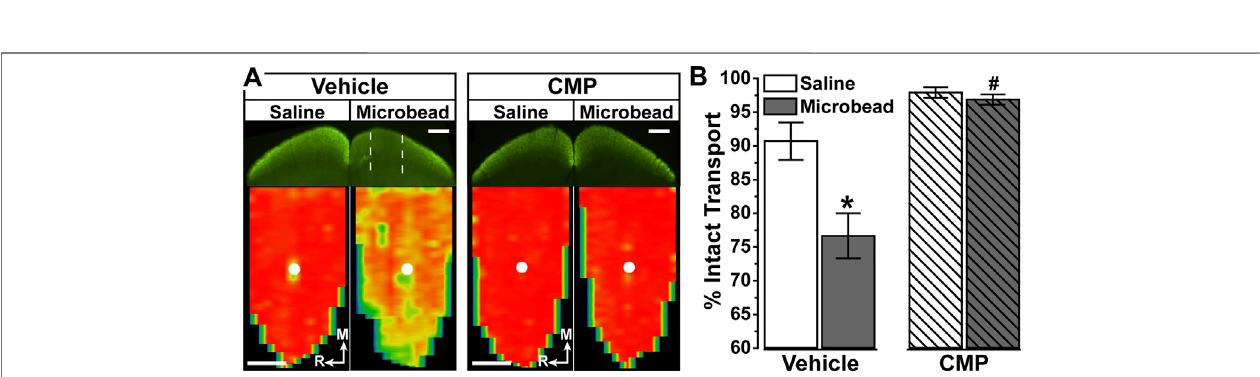
FIGURE 6 | Collagen Mimetic Peptides May Preserve Anterograde Axon Transport. (A) . Single sections through superior colliculus (top) showing regions of intact CTB transport (green) for mice receiving either vehicle (n (cid:1) 5) and CMP 03A (n (cid:1) 4). Colliculus serving projection from the saline-injected control eye had fully intact transport, while microbead-induced IOP elevation in the fellow eye created regions of degraded transport (dotted lines) in vehicle-treated mice. Retinotopic maps (bottom) reconstructed from serial sections through colliculus with optic disc indicated (white circles). Levels of intact CTB signal ranges from 0% (blue) to 50% (green) to 100% (red). Medial (M) and rostral (R) orientations are indicated. Scale (cid:1) 500 μ m. (B) . For vehicle-treated mice, intact transport signi fi cantly declined with microbead-induced elevations in IOP compared to the colliculus from saline eye (*, p (cid:1) 0.01). Compared to vehicle, CMP-treated microbead eyes demonstrated signi fi cantenhancementoftransporttothecolliculus(#, p (cid:1) 0.015).TherewasnodifferenceintransportbetweenvehicleandCMPmiceforsalinecontrols( p (cid:1) 0.44),and transport in drug treated mice showed no difference between microbead and saline eyes ( p (cid:1) 0.16). Data (cid:1) mean ± SEM.